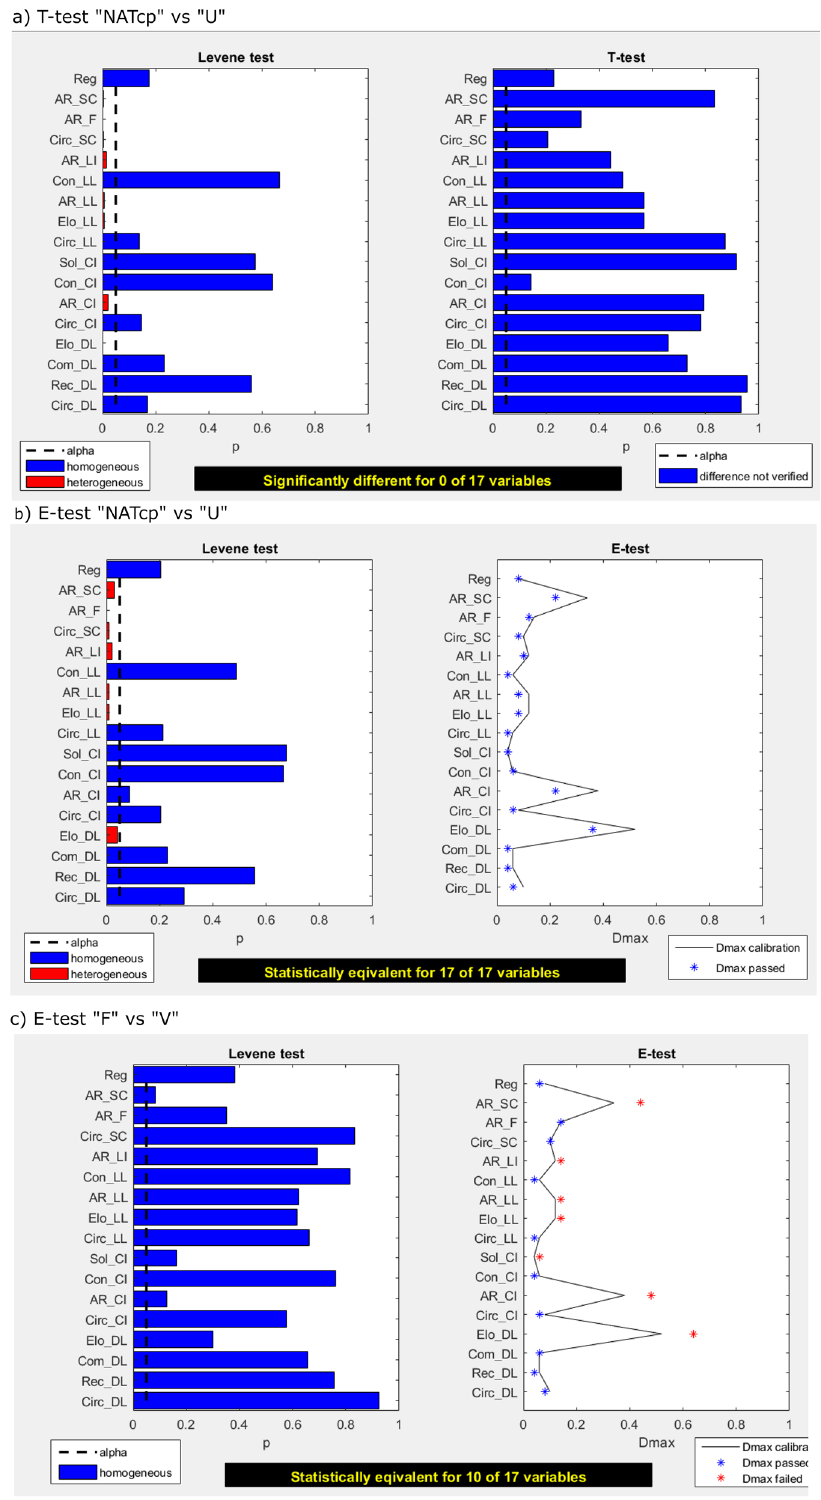
Figure 3. DendroScan screenshots displaying statistical test results. ( a ) Results of Levene tests (left) and t-tests (right) for natural ash sample “NATcp” tested versus experimental sample “U”. The left plot shows that Levene tests suggest homogeneous variances in 10 of the tested shape parameters. For the other 8 shape parameters, separate variance t-tests (“Welch tests”) were conducted. The right plot indicates no significant difference between “NATcp” and “U” for any of the 17 tested parameters. ( b ) DendroScan results for Levene-tests (left) and e-tests (right). The samples “NATcp” and “U” are verified to be statistically equivalent in all of the tested shape parameters. ( c ) In contrast, “F” and “V” show statistical equivalence for only 10 of the 17 shape parameters. Thus, these samples are still morphometrically distinguishable. The black line in the e-test plot represents the equivalence margin D max and is dependent on the standards used for